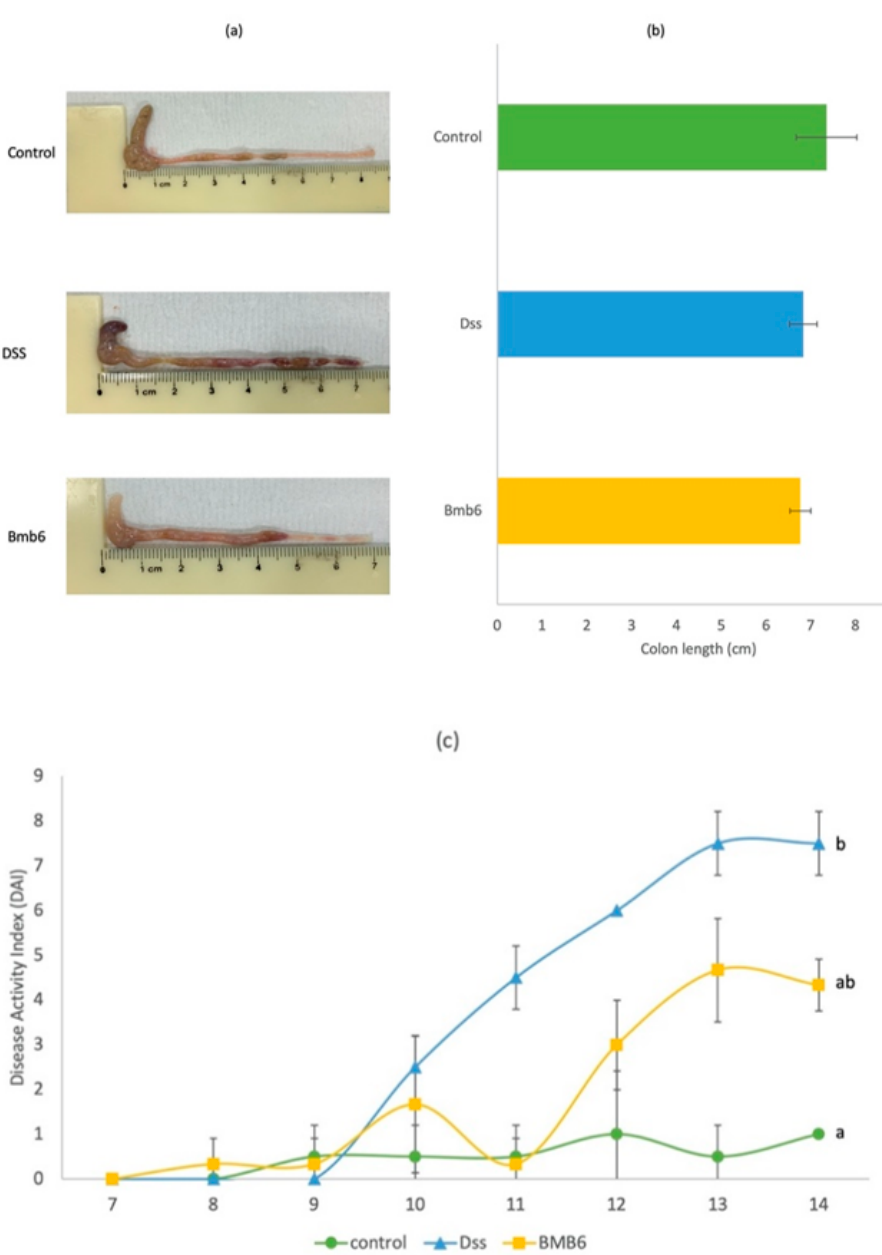
Figure 4. Effects of L. brevis Bmb6 on the ( a , b ) colon length and ( c ) disease activity (DAI) score of DSS-induced colitis mice. Data represent the mean ± standard deviation of six mice from each treatment group ( n = 6). Repeated measure ANOVA was performed for DAI score, and different lowercase letters indicate statistically significant differences ( p < 0.05).